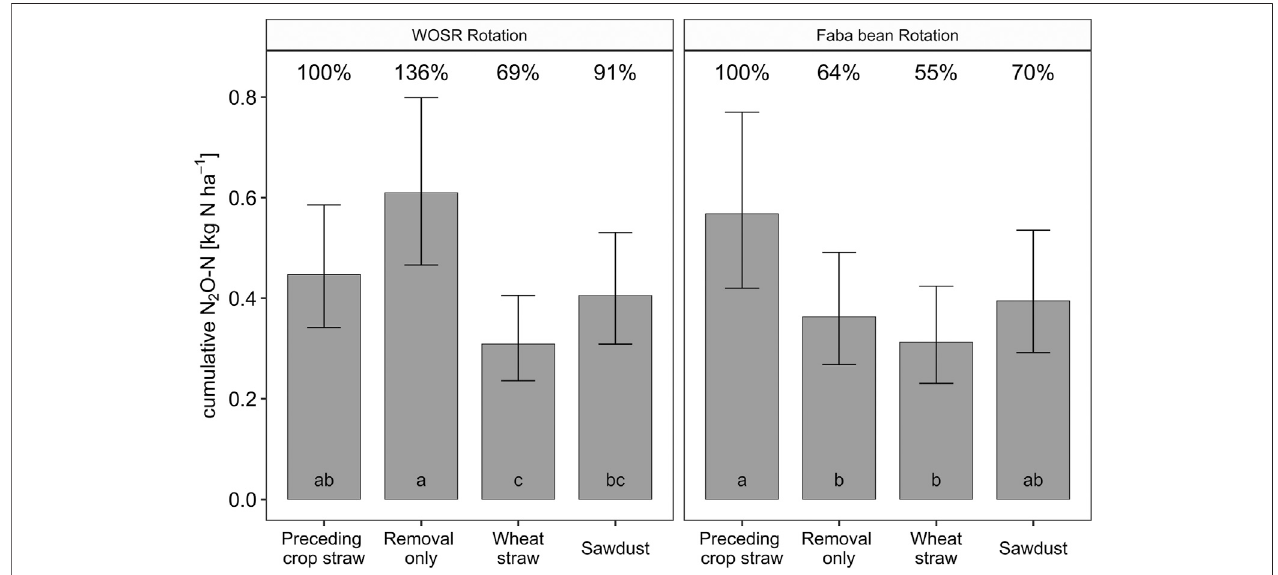
FIGURE 7 | Cumulative N 2 O-N emissions calculated with the regression model at average abiotic emission conditions (i.e., average period length, temperature sum, moisture status, and N-source status) and re-transformed from log-transformation; minor letters indicate signi fi cant differences of the model estimates ( p < 0.05) per crop rotation; error bars indicate the 95% con fi dence interval; percent values refer to the control treatment.